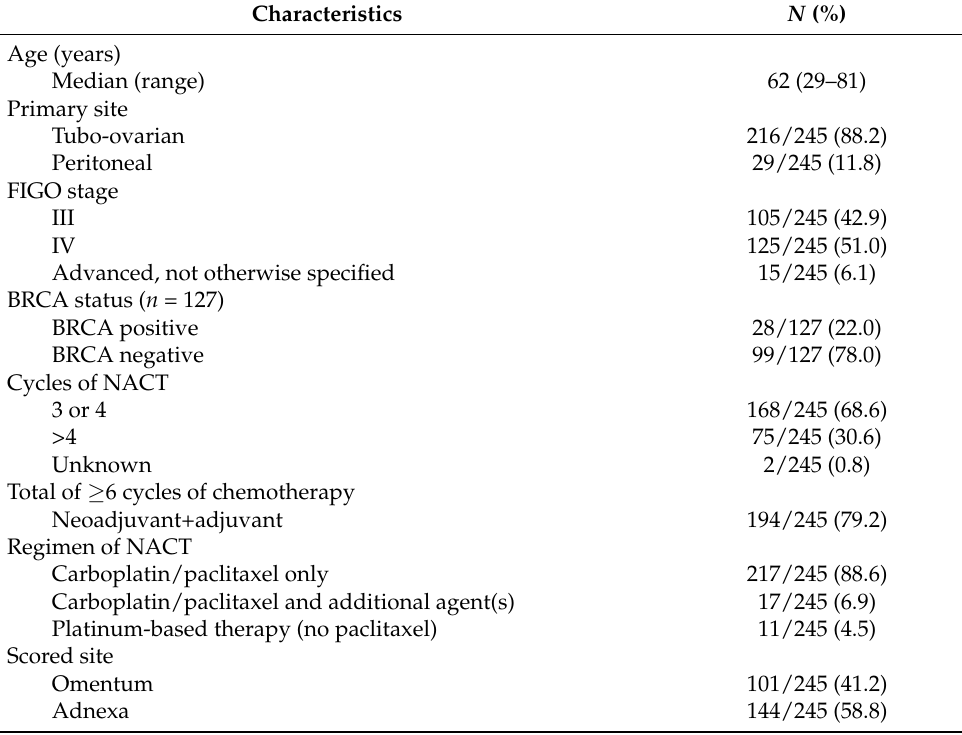
Table 1. Baseline characteristics of the study cohort ( n =